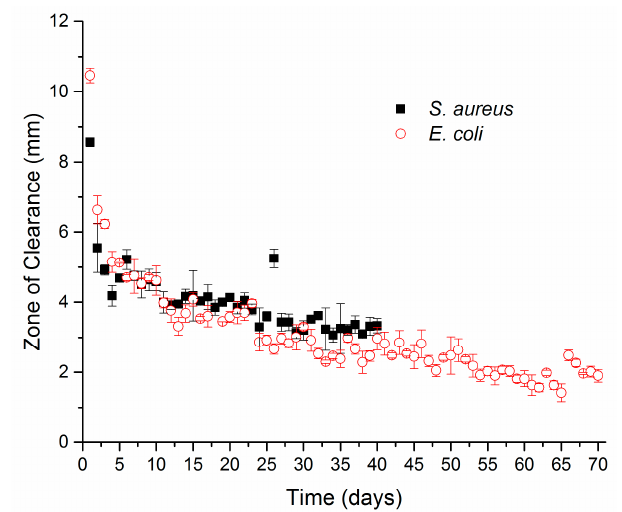
Figure 6. In vitro bioactivity of MNC released from pCD- β at 1:0.32 showed extended clearing of both Gram-positive S. aureus ( A ) for > 40 d and Gram-negative E. coli ( B ) for > 70 d. Each day, MNC-loaded pCD hydrogel disks were placed on a fresh bacteria lawn, incubated for 24 h, and had the zone of clearance measured with calipers prior to repeating the process. All samples were replicated three times with average ± std deviation (mm) shown.